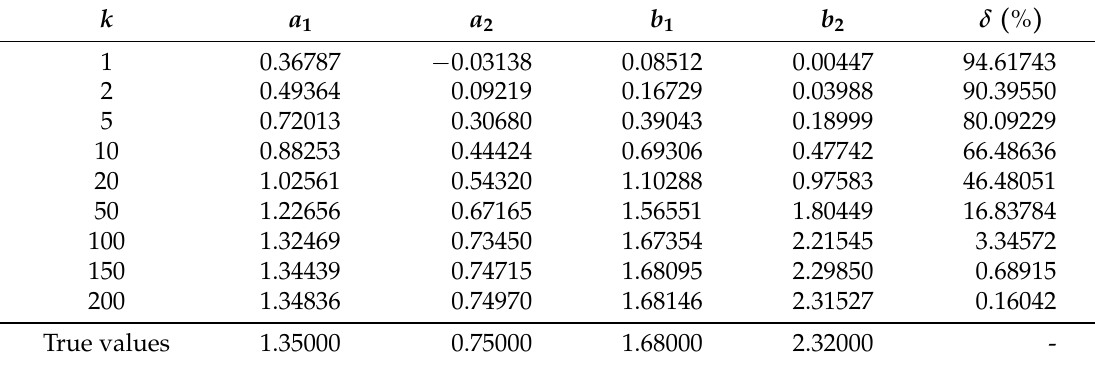
Table 2. The GI estimates and their errors with σ 2 = 0.20 2